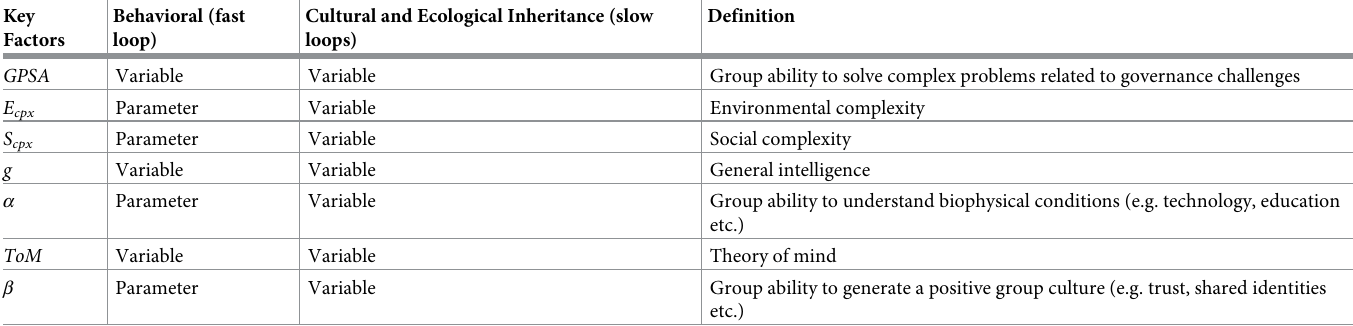
Table 1. Time-scale dependent model elements as parameters and